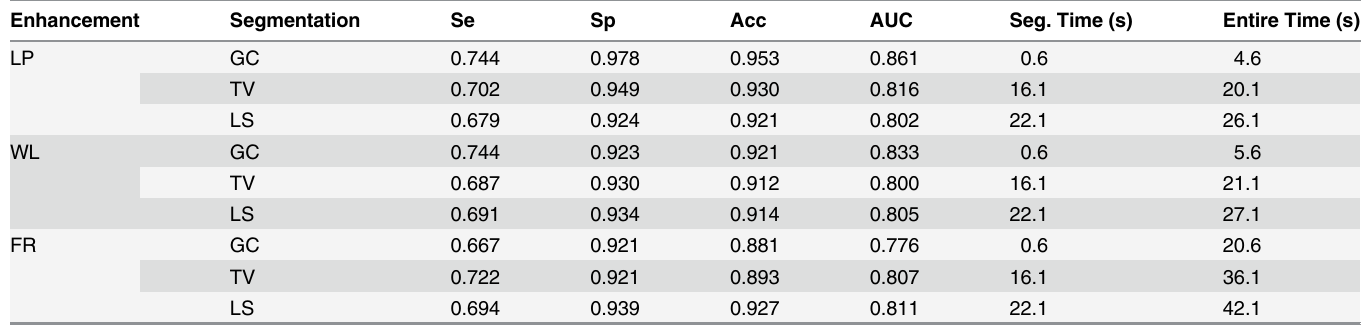
Table 2. Segmentation performance of different possible combinations of three enhancement methods (LP, WL, FR) and three segmentation meth- ods (GC, TV, LS) on the DRIVE dataset. LP, WL and FR denote local phase, wavelet and Frangi ’ s eigenvalue based enhancement filters respectively. GC, TV and LS denote graph cut, total variation and level set based segmentation methods respectively. Se : sensitivity; Sp : specificity; Acc : accuracy; AUC : area under the curve. Enhancement